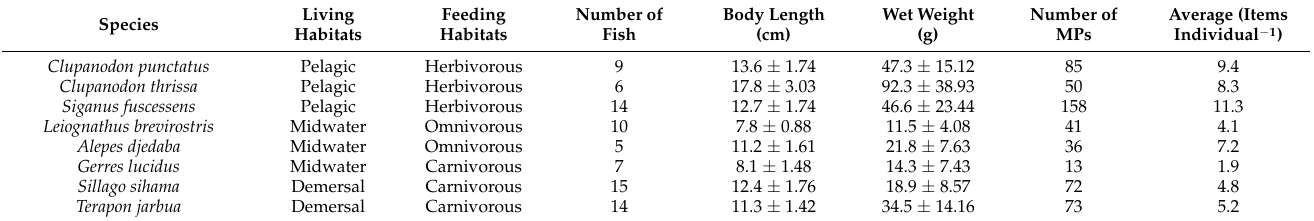
Table 1. Microplastics (MPs) in fish from the coastal areas of central and western Guangdong province, China.